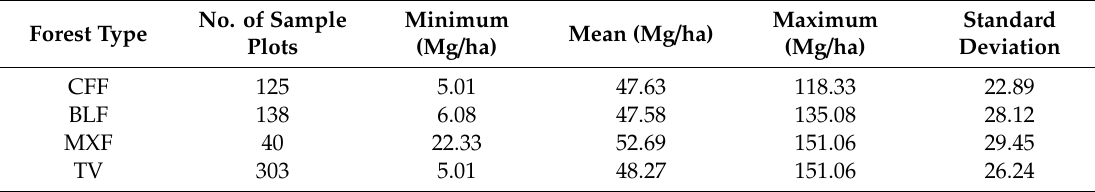
Table 1. Summary of the sample plots by forest type (CFF, coniferous forest; BLF, broadleaf forest; MXF, mixed forest; TV, total vegetation).